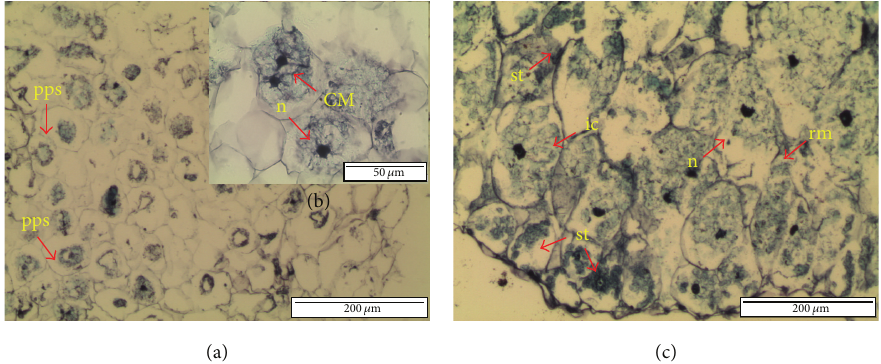
Figure 3: Cross-section of cryopreserved PLB. (a) Original PLB. Cells were in plasmolysis and pps were significant. (b) Higher magnification showing cell being intact and mitotic activity in cryopreserved PLB. (c) Regenerated portion. Cells were intact with dense nuclei, and some rupture membrane and starch were observed (CM: cell mitosis ic: intact cell; n: nucleus; pps: periplasmic space; rm: rupture membrane; st: